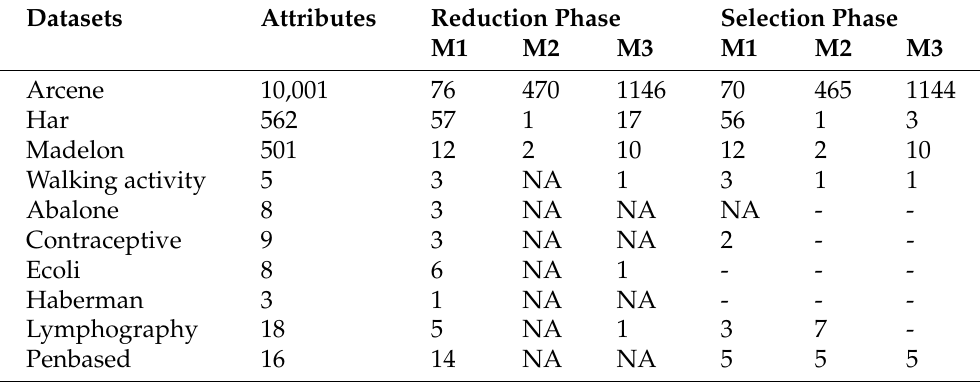
Table 3. Number of optimised features after went through phase 2 and phase 3.